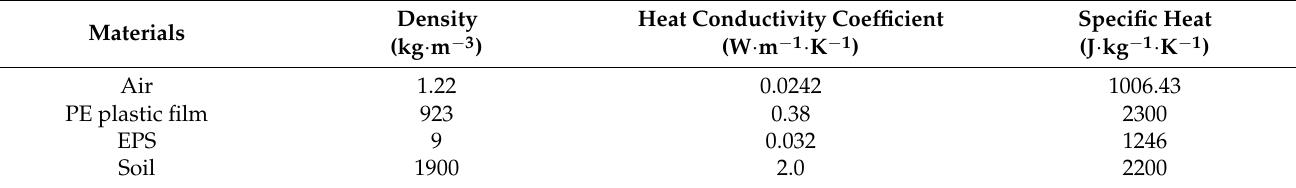
Table 1. Material property parameters in the mushroom solar